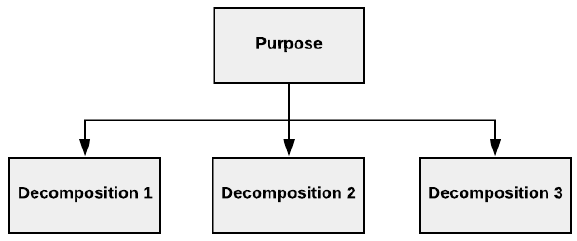
Figure 3. A generic purpose tree and its KPIs decomposition.